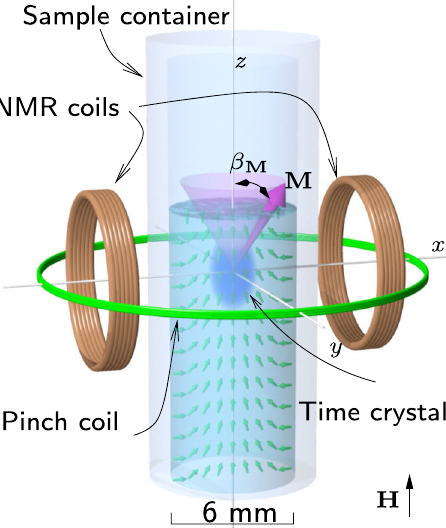
Fig. 1 Schematic illustration of the experiment. The super fl uid 3 He sample is contained in a quartz glass cylinder. The magnon time crystal (blue blob) is trapped in the middle of the container by the combined effect of a minimum in the static magnetic fi eld, created using a pinch coil (green wire loop), and by the spatial distribution of the super fl uid orbital momentum L (small green arrows). The coherent precession of magnetisation M (magenta cone) in the time crystal is observed using transverse pick-up coils. The static magnetic fi eld H is oriented parallel to the axis of the cylinder. The ripple on the super fl uid free surface is added for illustrational purposes. The two-level time crystal is schematically illustrated in Fig.